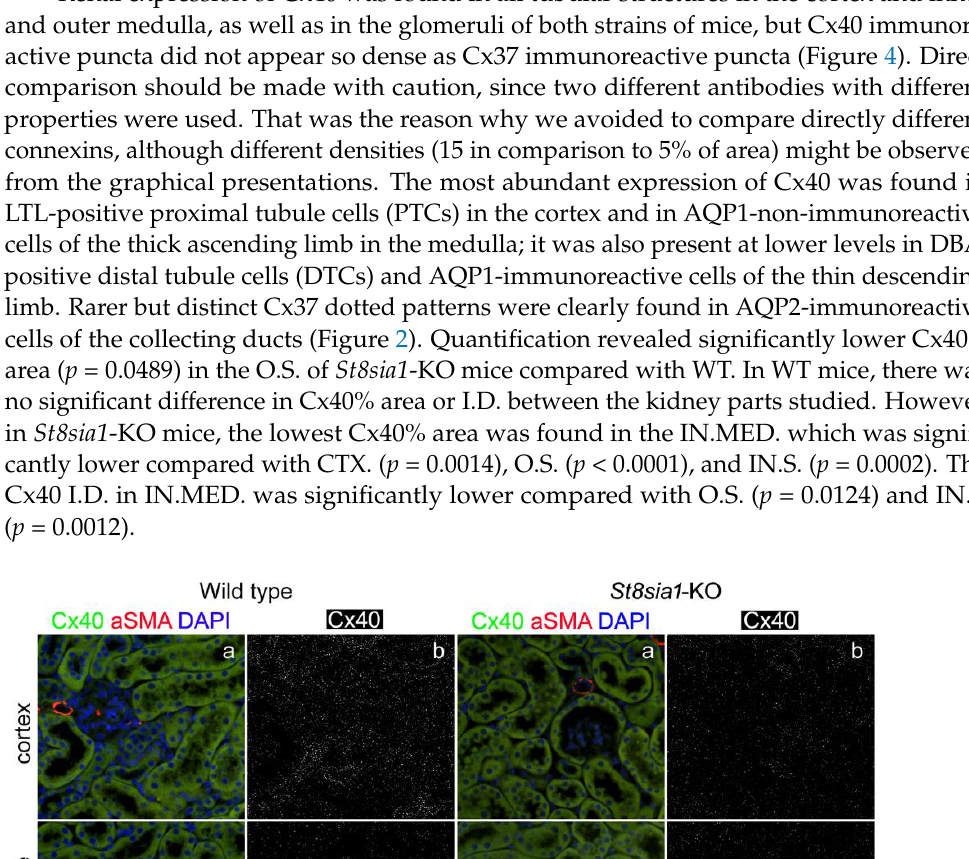
Figure 4. Expression of connexin 40 in different renal parts of the wild type and St8sia1 -KO mice . WT — wild-type mice; St8sia1 -KO — St8sia1 knockout mice; CTX. — cortex; O.S. — outer stripe of outer medulla; IN.S. — inner stripe of outer medulla; IN.MED. — inner medulla; % area — percentage of sec- tional area occupied by Cx40 immunofluorescence; int.den. (RFU) — integrated density (relative flu- orescence units). Column a — representative photomicrographs of the indicated kidney section areas stained with Cx40 (green) and alpha-smooth actin (red) antibodies; cell nuclei are stained in blue. Column b — (same section as a) processed and thresholded photomicrographs prepared for analysis (inverted black for white on thresholded green image). Statistically significant difference between WT and St8sia1 - KO: * p < 0.05 (t-test for unequal variances). Comparison between different kidney areas in the same group: WT — there was no significant difference; for St8Sia1- # p < 0.05, ## p < 0.01